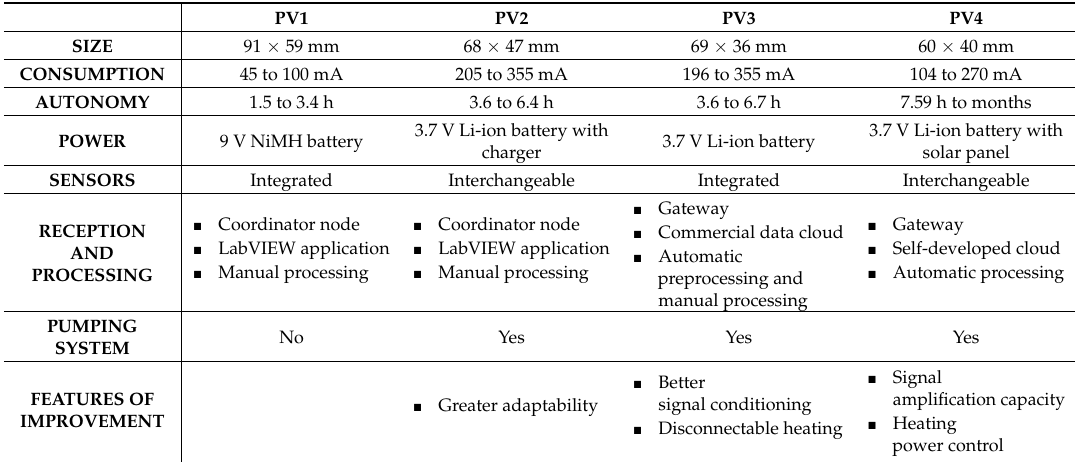
Table 1. Main characteristics of each of the prototype versions (PVs) designed.